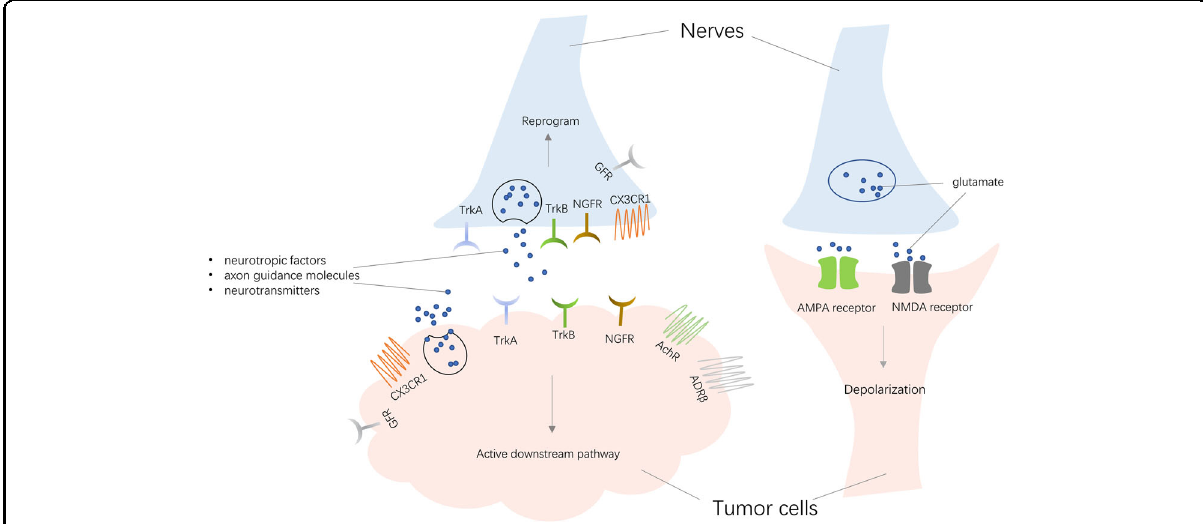
Fig. 2 Two direct ways of communication between tumor cells and nerves. Tumors release molecules also secreted by nerves, including neurotropic factors, axon guidance molecules, and neurotransmitters. These factors act on receptors of nerves to drive the nerve reprogramming, while they can also act on tumor receptors to activate downstream signaling. In addition to the paracrine model, tumors and nerves can form the synapses for depolarization to promote tumor progression. TrkA tyrosine kinase receptor A, TrkB tyrosine kinase receptor B, NGFR nerve growth factor receptor, AchR acetylcholine receptor, ADR β adrenoceptor β receptor, CX3CR1 C-X3-C motif chemokine receptor 1, GFR glial cell-derived neurotrophic factor family